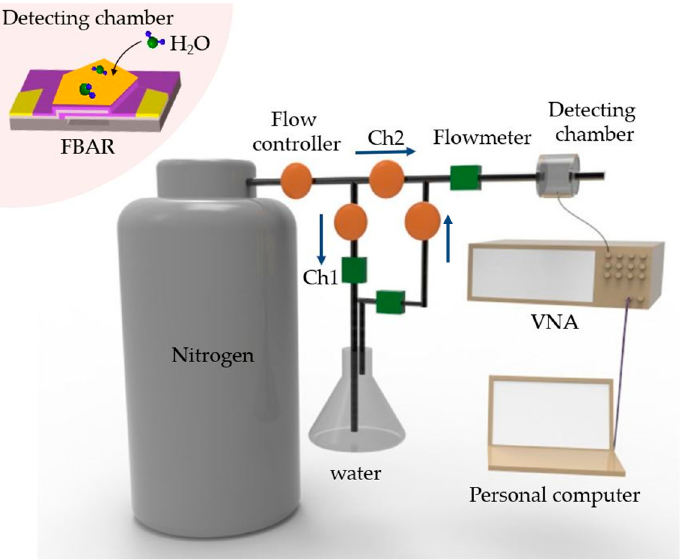
Figure 1. Cartoon showing the experimental setup for humidity sensing using polyelectrolyte (PET)-coated film bulk acoustic resonator (FBAR).